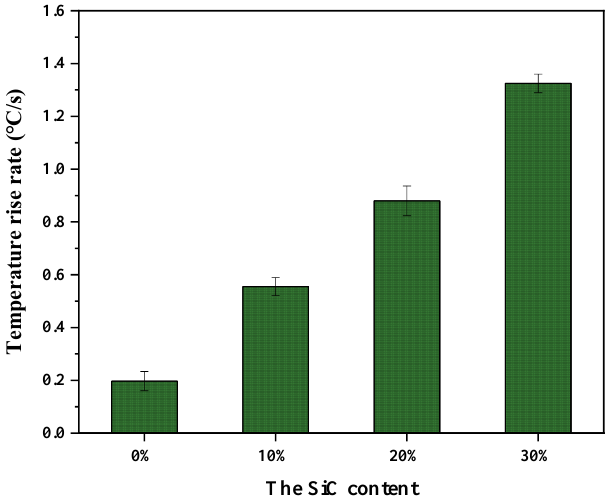
Figure 11. Temperature rise rate of UMLs with different SiC contents.